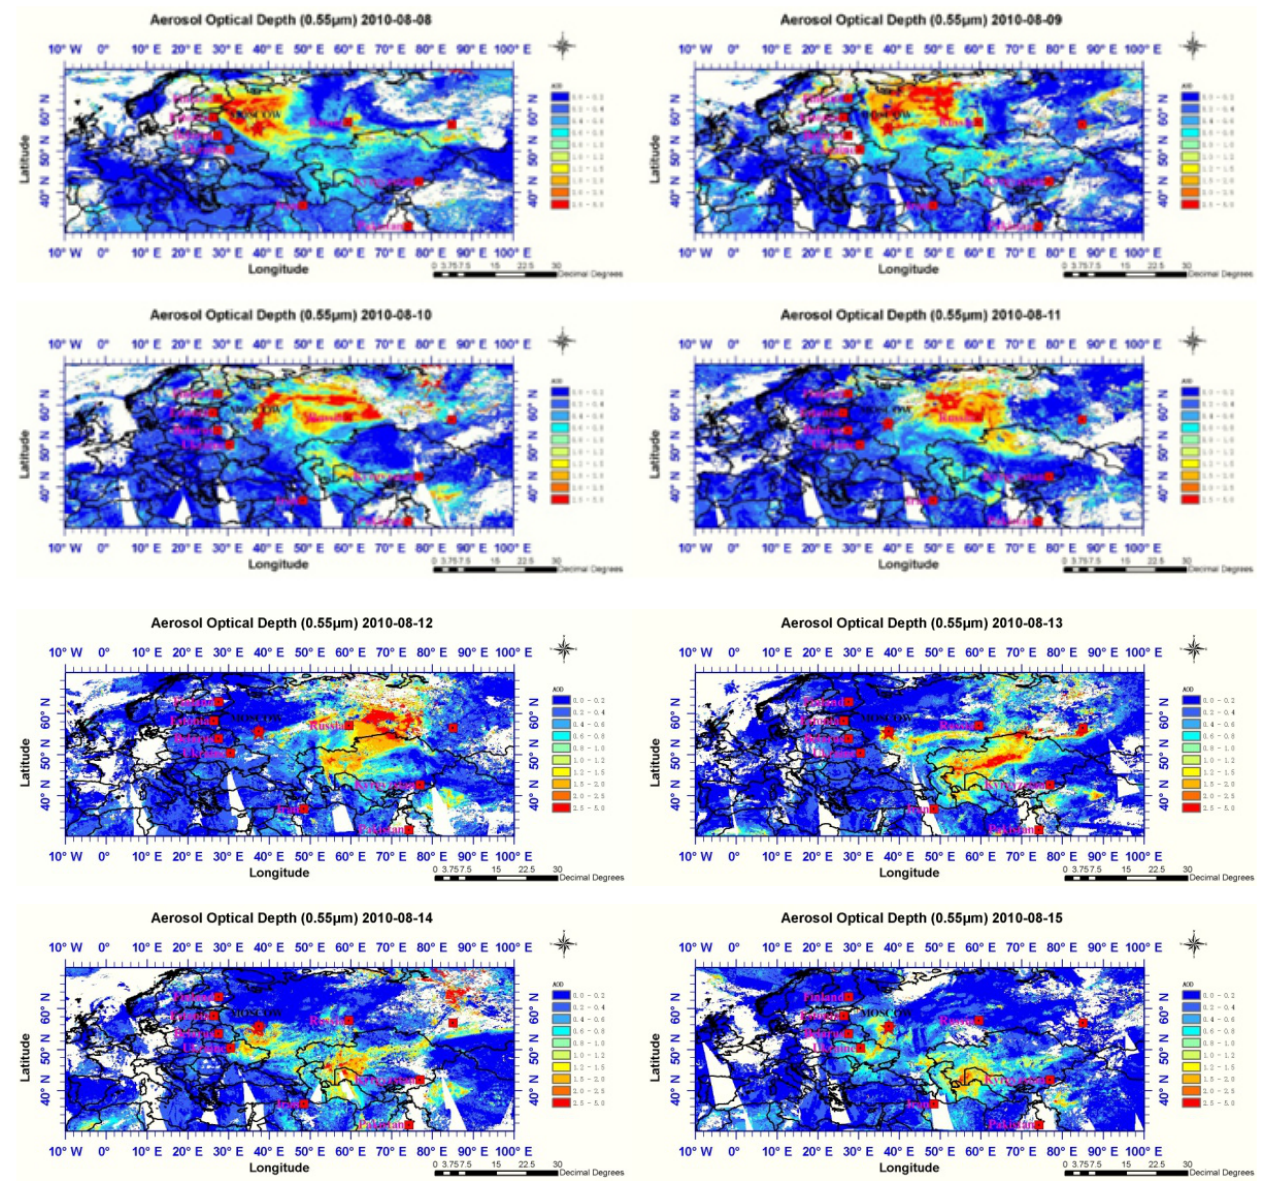
Figure4. AOD (at 0.55 μ m) distribution over the study area for the period from 31July to 15August 2010. The AOD was obtained from integration of the AOD retrieved from three different methods as described in the